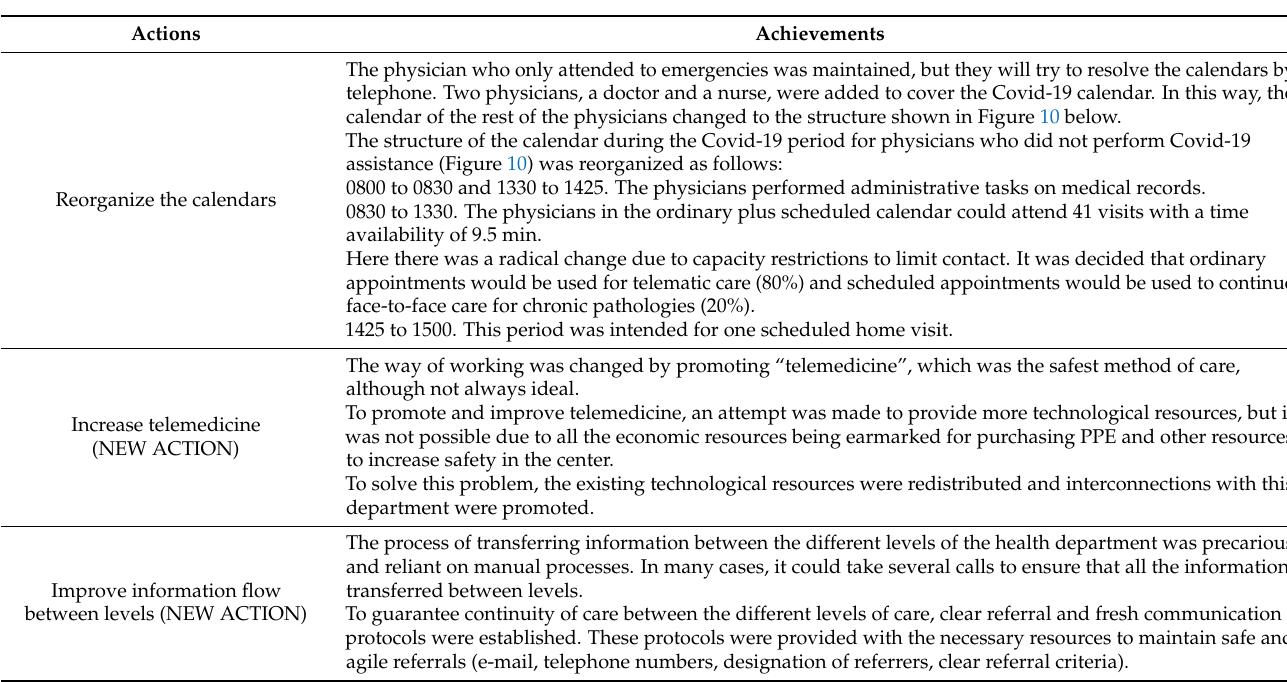
Table 8. Action plan and